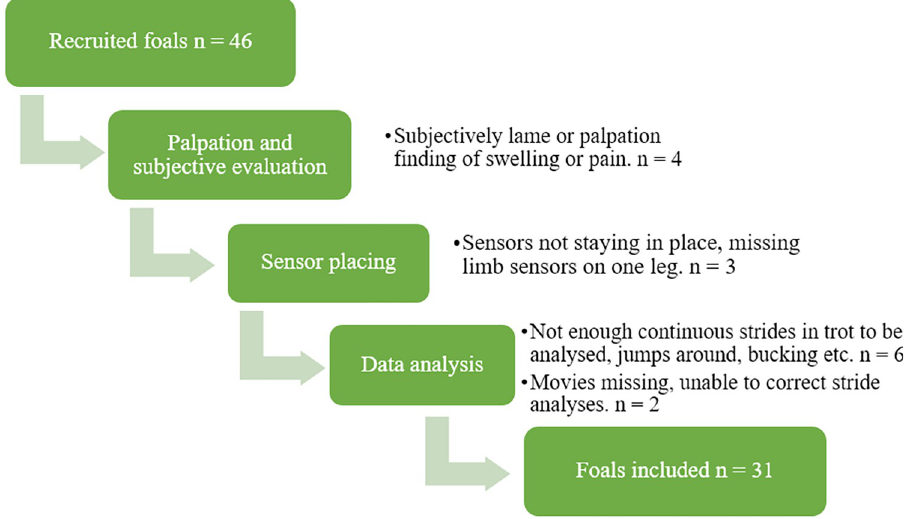
Fig 2. Exclusion flowchart for Warmblood foals after recruitment, with number (n) of foals excluded in each section and cause of